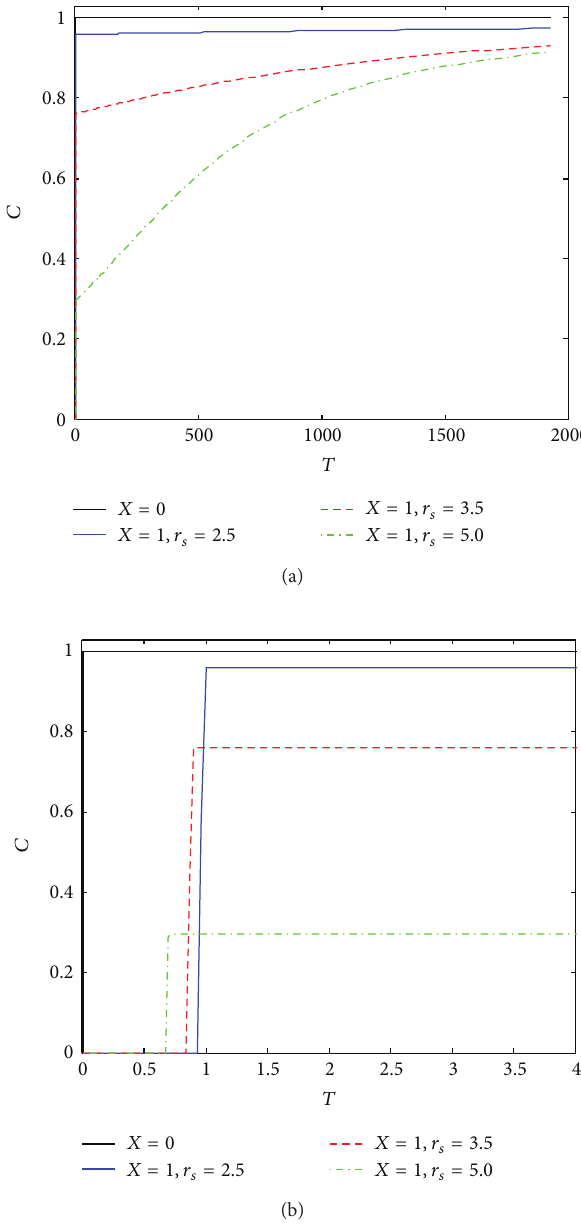
Figure 2, the blue dashed curves present an early stage and the red dash-dot curves correspond to a later moment. It is shown that particle concentrations 𝐶 and 𝑆 decrease along the distance 𝑋 behind the concentration front while remain zero ahead of the front. The characteristic curve deviates from straight line when 𝑇 > 0 . The larger the time, the higher the